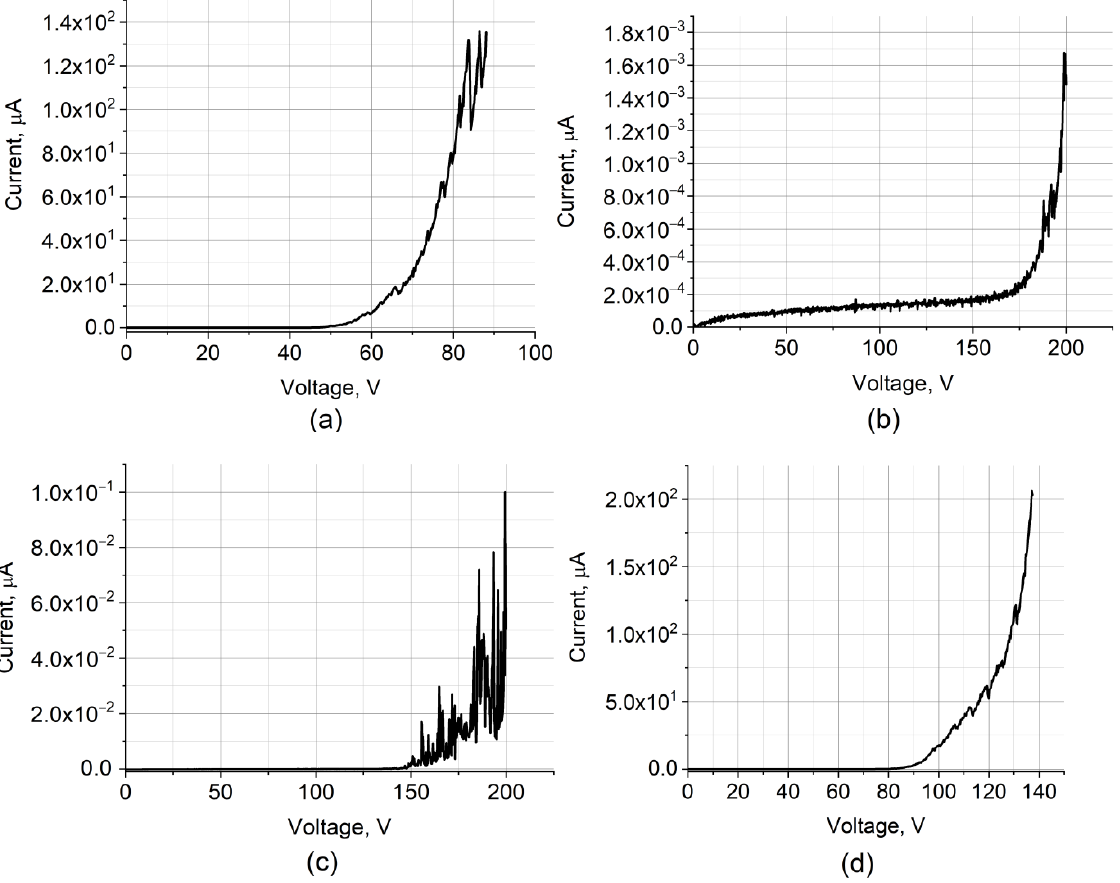
Figure 11. Current–voltage characteristics of layers based on: ( a ) SWCNT, ( b ) rGO, ( c ) Hybrid nanostructures rGO/SWCNT, and ( d ) rGO(bl)-SWCNT.